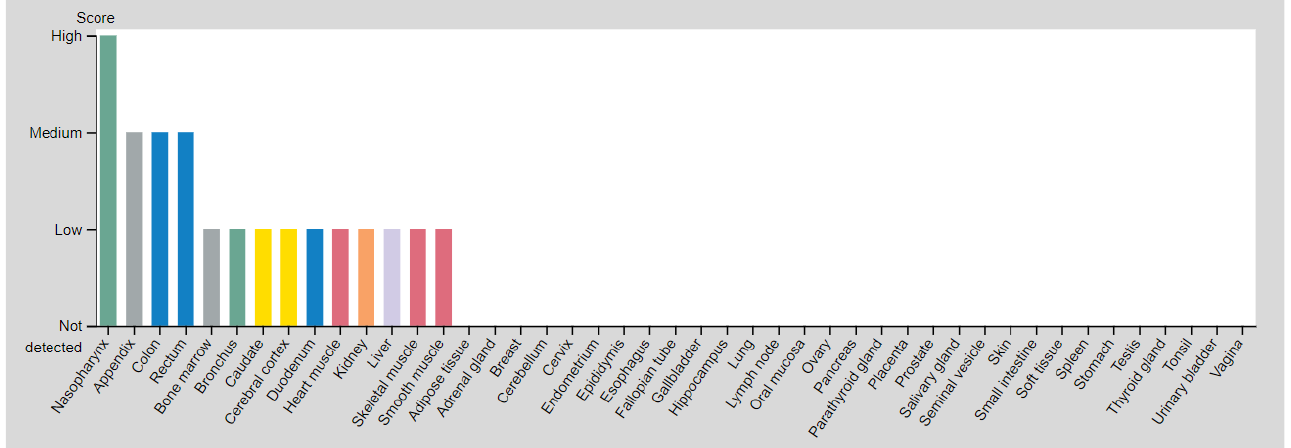
Figure 1. The inducible nitric oxide synthase (iNOS) expression in the healthy organs of the human body (https://www.proteinatlas.org/ENSG00000007171-NOS2/tissue accessed on 17 November 2022).